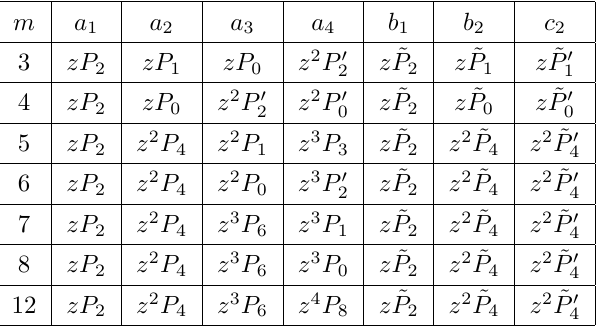
C = m . (cid:1) (cid:0)